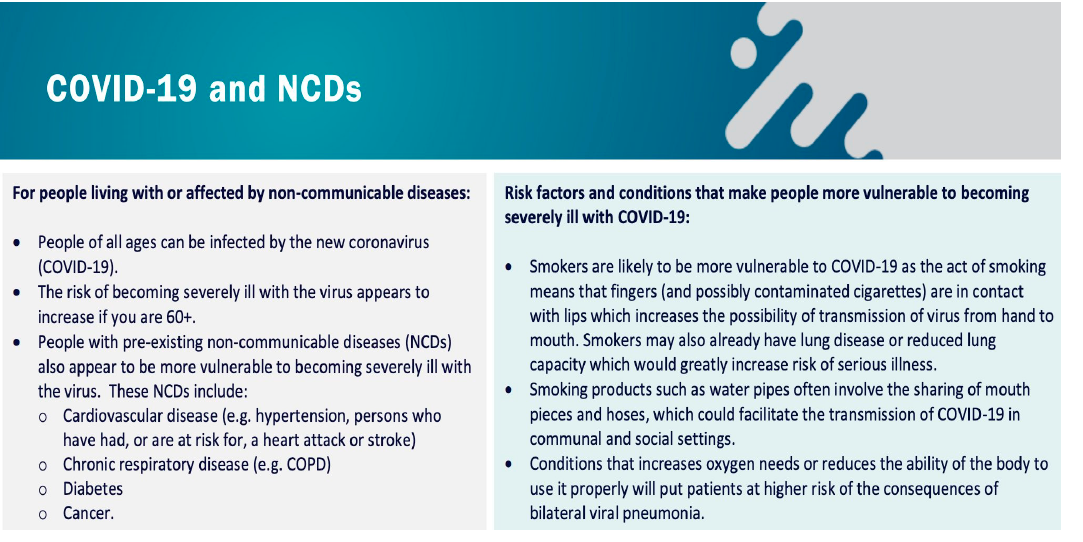
Figure 2. World Health Organization (WHO) guidelines and information intended for people with noncommunicable diseases [25]. Abbreviations: COPD = Chronic obstructive pulmonary disease.